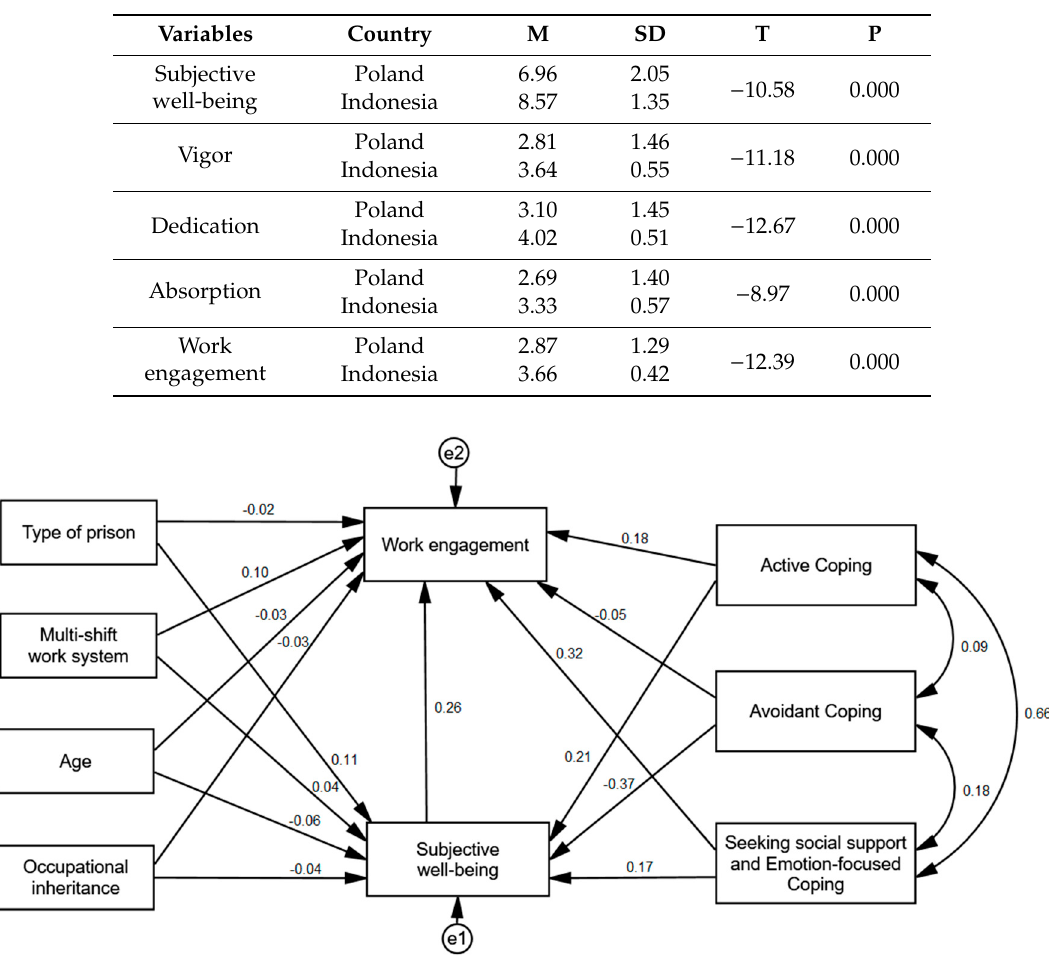
Table 2. Comparison of subjective well-being and work engagement among Polish and Indonesian prison o ffi cers (POs).